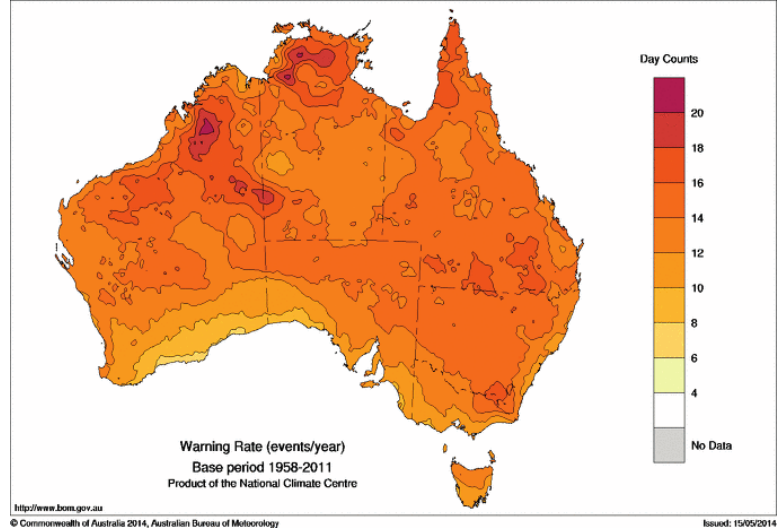
Figure 7. Average annual number of TDPs with positive EHF in the period